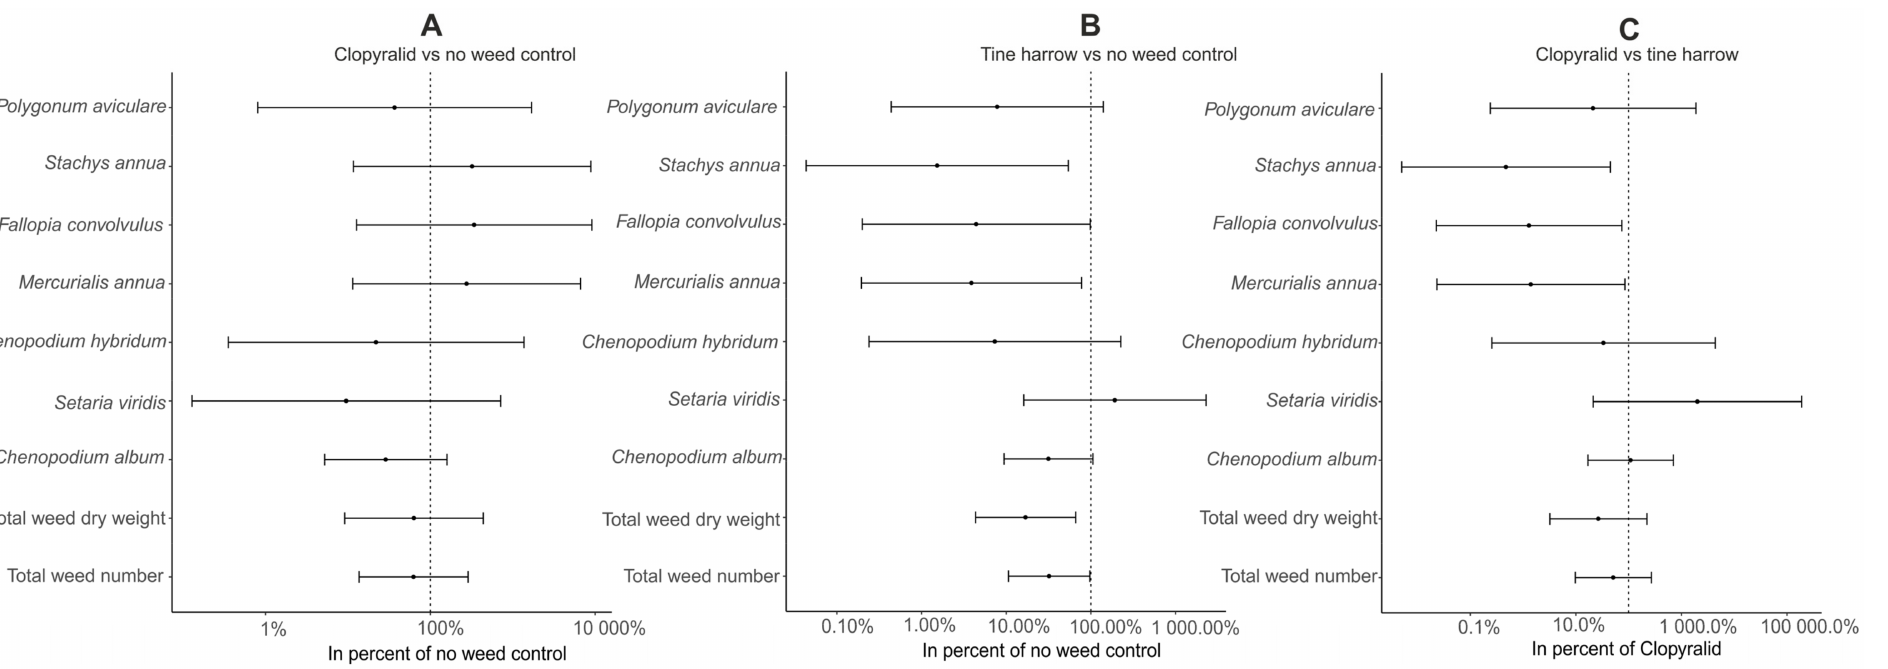
Figure 6. Differences between three weed management treatments (clopyralid, tine harrow and no weed control) in the fine-scale survey (FS): relative differences in (=ratios of) weed abundances and total biomass values for each pair of treatments ( A – C ). Dots: mean relative difference; whiskers: 95% confidence intervals based on Tukey-type post hoc test of GLMM models. A relative difference is significant at 5% level, if its confidence interval does not cross the vertical dotted line at